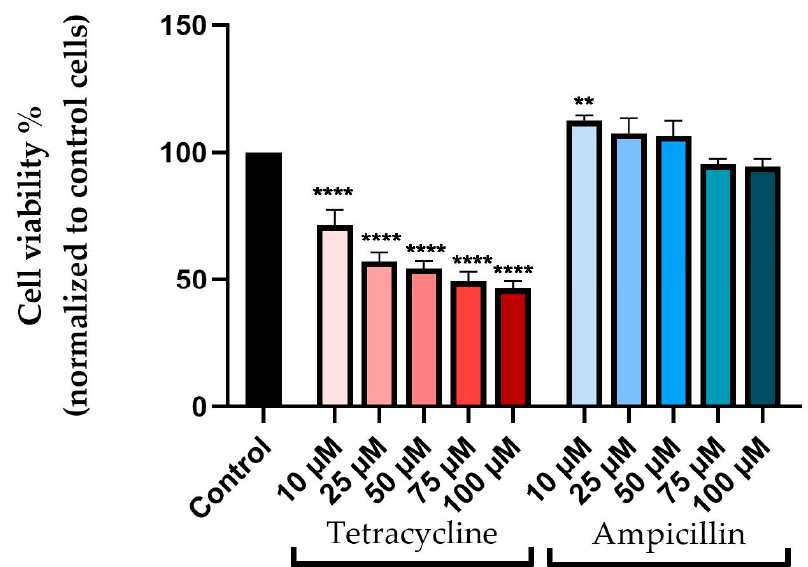
Figure 1. In vitro evaluation of the viability of pharyngeal carcinoma cells—Detroit-562—after stimulation with tetracycline and ampicillin (10, 25, 50, 75, and 100 uM) for 72 h following treatment. The results are expressed as viability percentages (%) normalized to control cells (unstimulated) and expressed as mean values ± SD of three independent experiments performed in triplicate. The statistical difference between the control group and the tetracycline and ampicillin-treated group was achieved by applying one-way ANOVA analysis, followed by Dunnett’s multiple post-test comparisons (** p < 0.01; **** p <